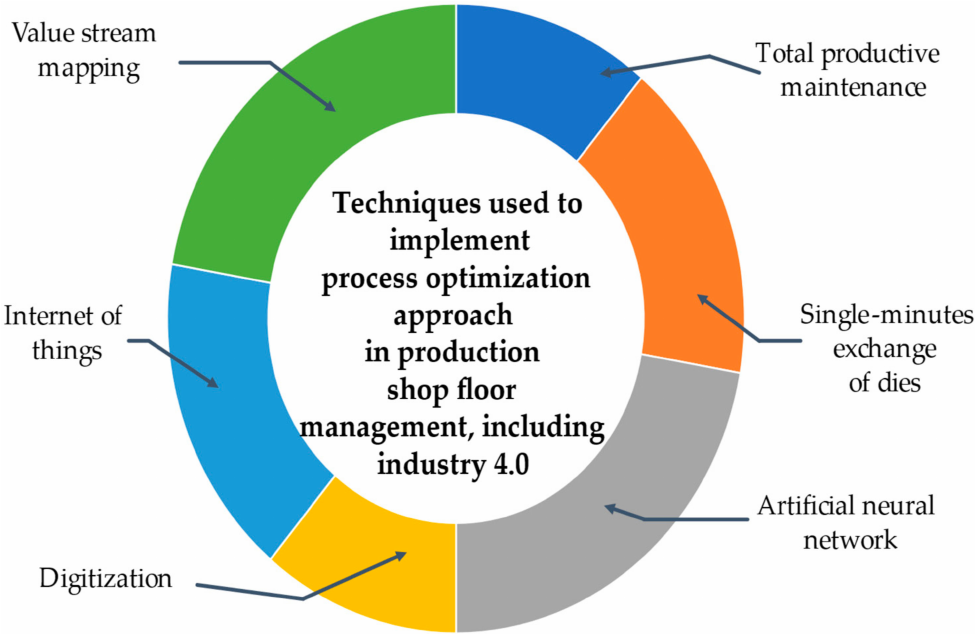
Figure 1. Preferred techniques for implementing a process optimization